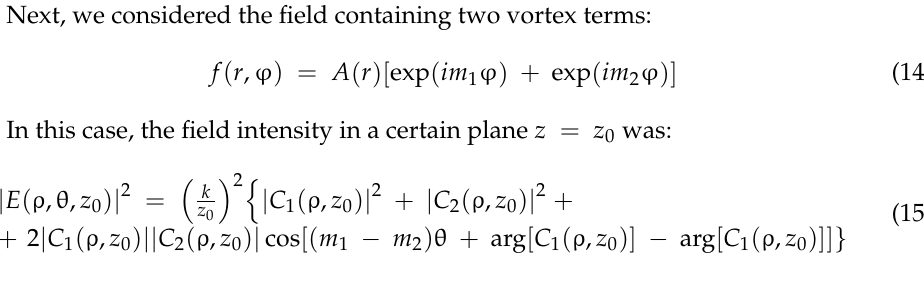
Figure 3. Simulation results for the field defined by Equation (1) in the presence of a single vortex phase of order m 1 = 1 (the rest of the description is as in Figure 2).